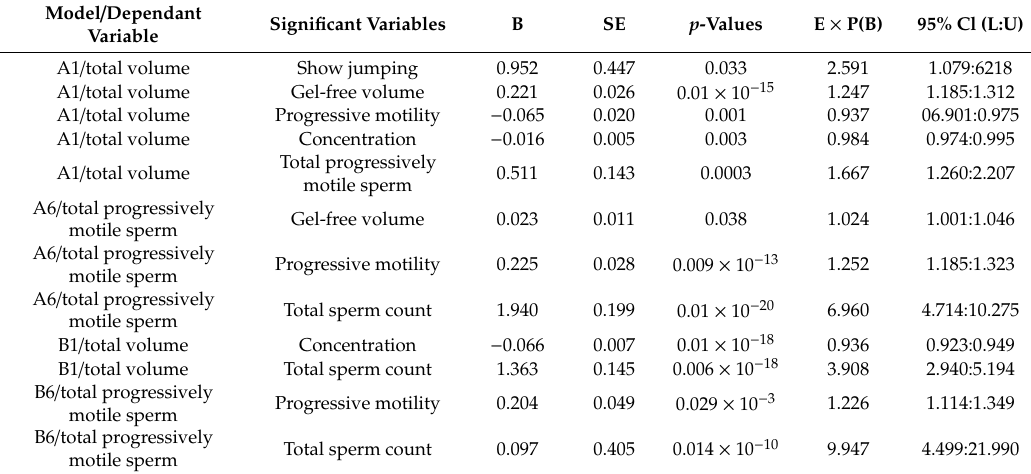
Table 7. Multivariate model variables that were significant when tested against the dichotomous outcome of being above or below the industry standard measure for each of the semen characteristics measured in competing ( n = 400 semen collections) and non-competitive ( n = 1201 semen collections: show jumping, n = 422; dressage, n = 397; eventing, n = 382) warmblood sports horse stallions, collected from 2009 to